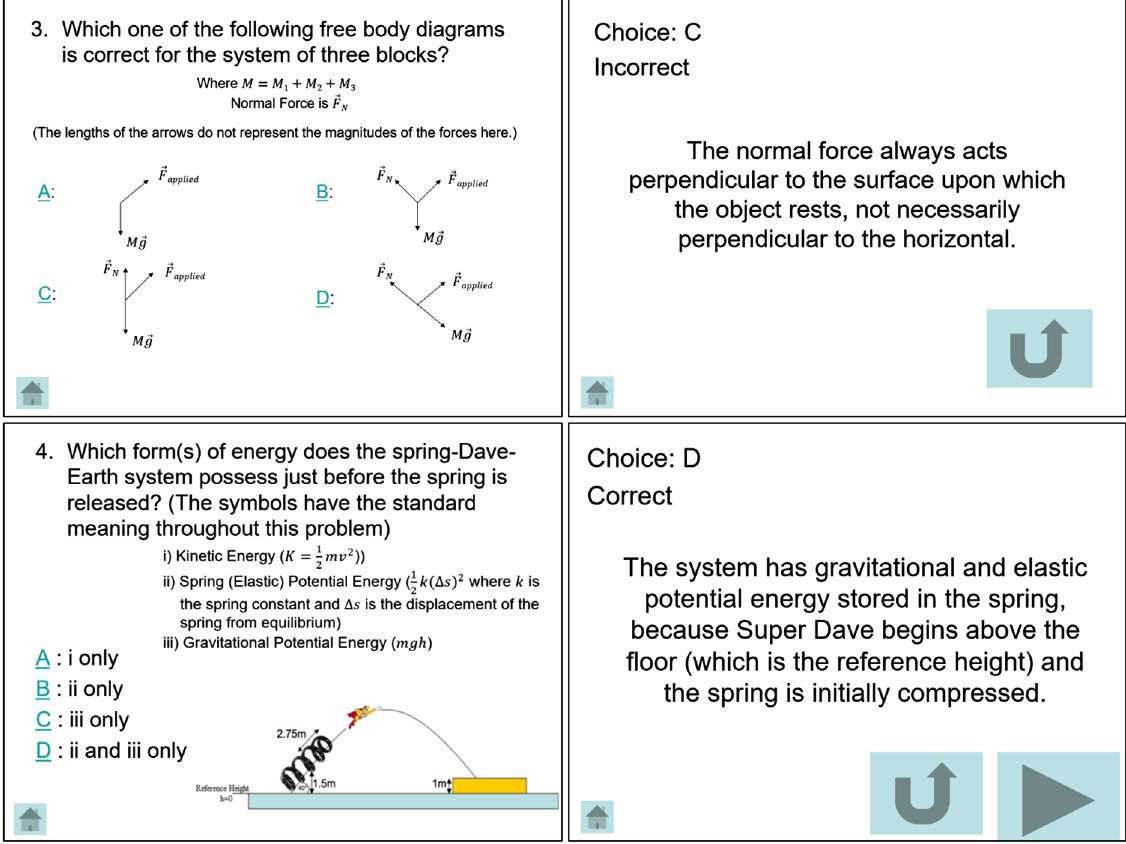
FIG. 2. Examples of two subproblems (left) and two associated responses when students select a choice (right) from tutorials focusing on Newton ’ s second law (top) and conservation of energy and work-energy theorem (bottom). For the subproblems, students can either click on a particular option in the multiple choice or click on the home button in order to access any of the previous subproblems and associated